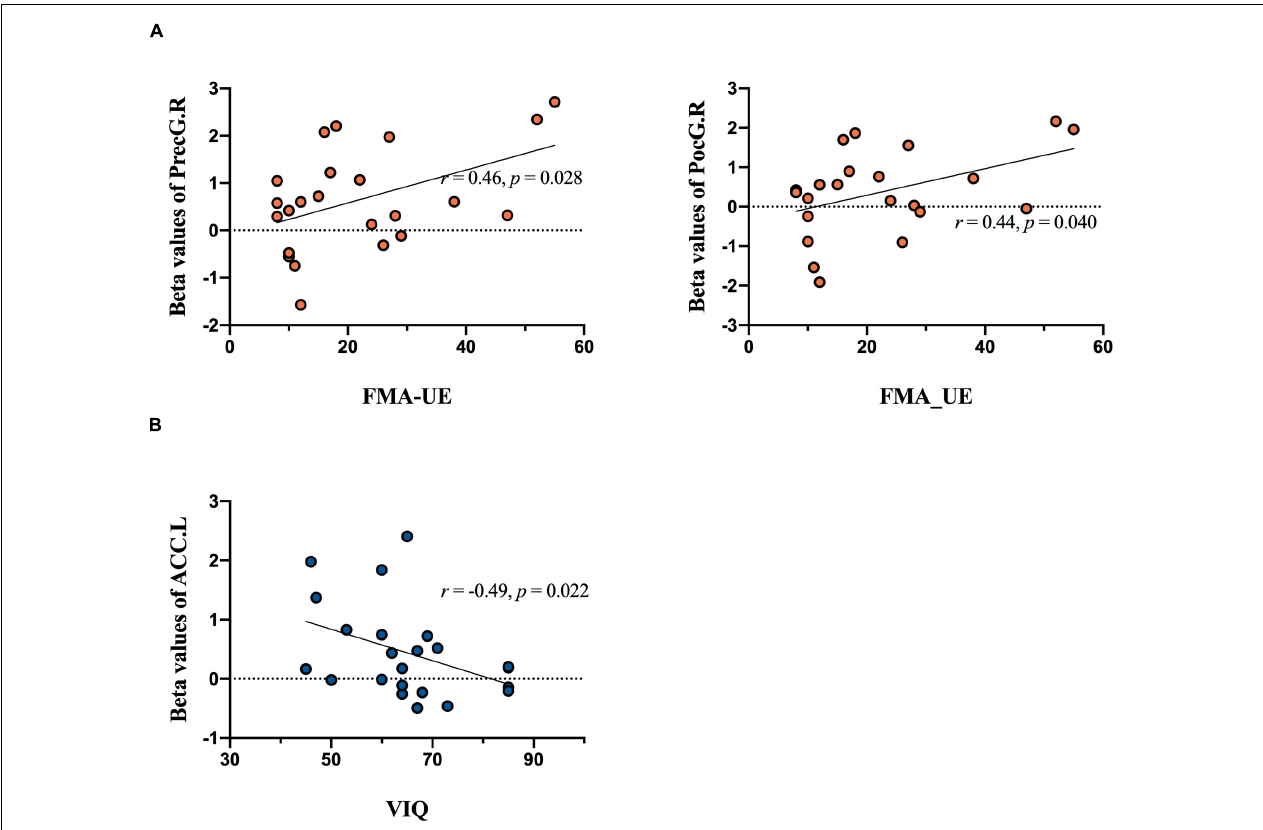
FIGURE 6 | Correlation analysis results. Brain activation during tasks between groups in relation to behavioral performance is included. The upper plane in the figure shows the correlation analysis of extracted beta values from MarsBaR in each region of interest during the motor execution task and the FMA-UE score. (A) Significant positive relationship between PreCG.R and FMA-UE score [left panel, unaffected hand (UH)] and PoCG.R and FMA-UE score [right panel, unaffected hand (UH)]. The lower plane in the figure shows the correlation analysis of imagery task-related activity and the VIQ score. (B) Significant negative relationship between ACC.L and VIQ score [unaffected hand